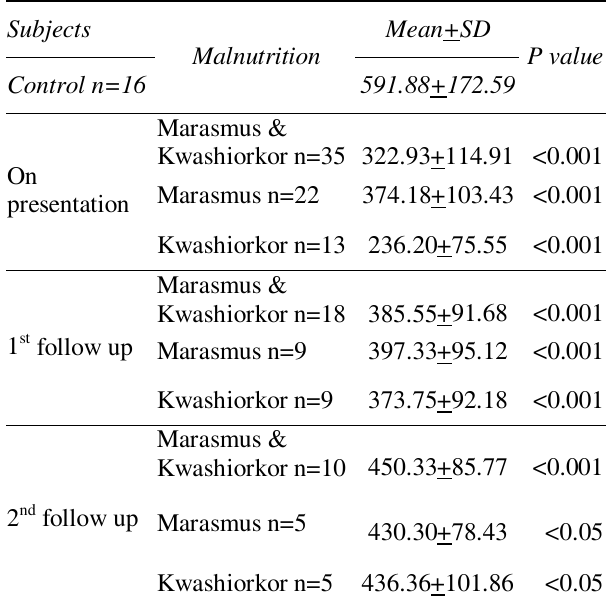
Table 5: Total antioxidant activity level (µmol/L) in control, marasmus & kwashiorkor on presentation, 1 st & 2 nd follow